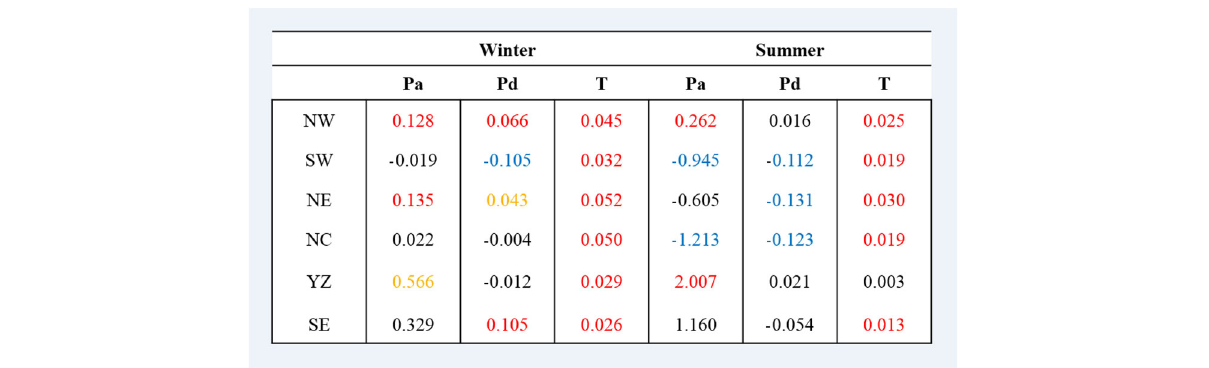
Table 1 Trend coefficient of precipitation amount (Pa), precipitation days (Pd), and temperature (T) during winter and summer in six